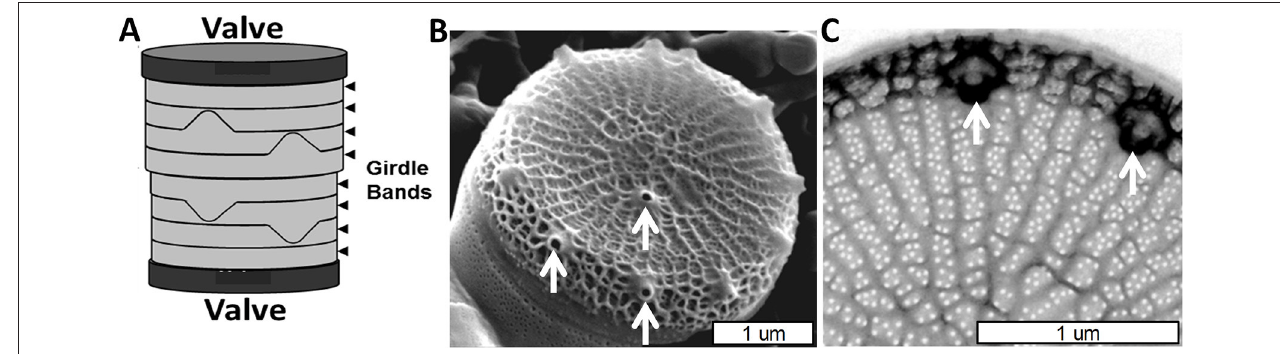
FIGURE 1 | Cell wall structure for T. pseudonana . (A) Schematic of the entire frustule, indicating valves and girdle bands. (B) Scanning electron micrograph (SEM) of the valve and associated first girdle band. (C) Transmission electron micrograph (TEM) of the valve, highlighting the rib and pore structure. White arrows denote a subset of the fultoportulae. From Hildebrand et al. (2006), reproduced with